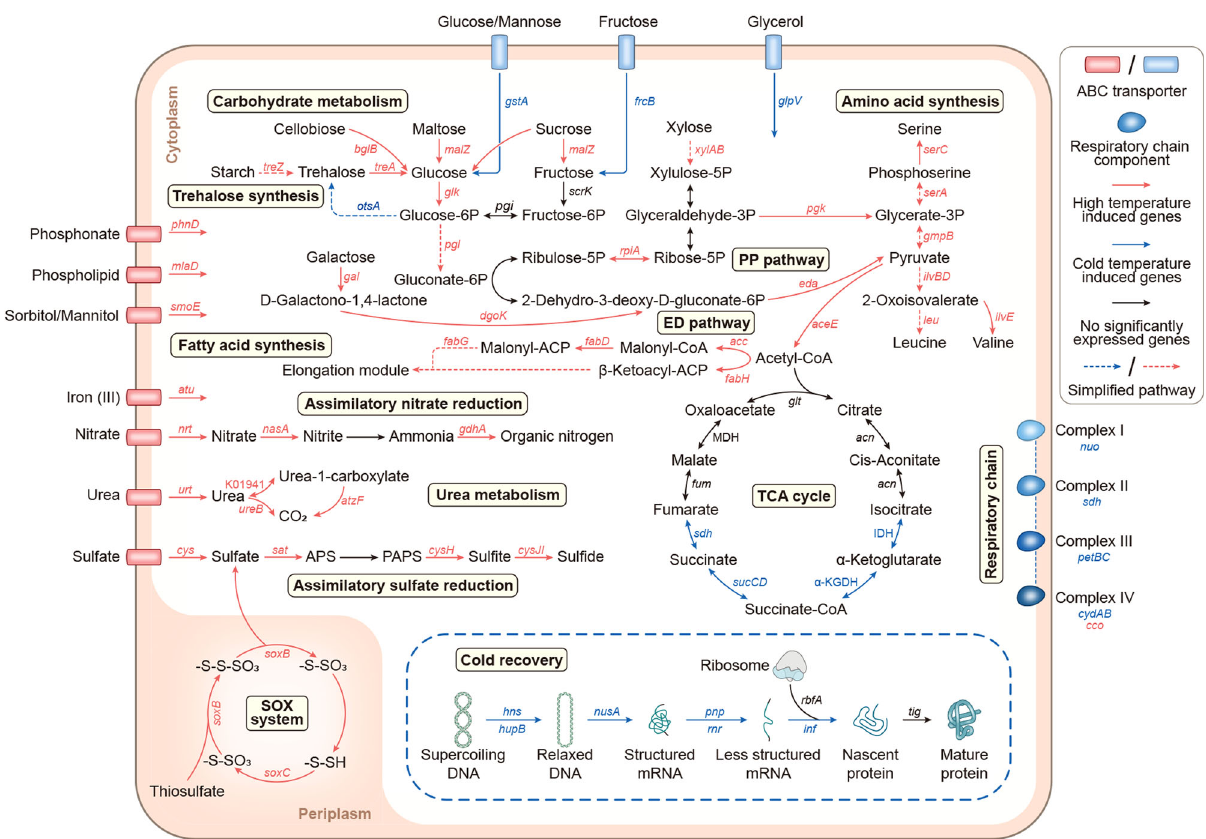
Fig. 4 Differentially transcribed genes and pathways in L. salsilacus with temperature variation. Reads per kilobase per million mapped reads (RPKMs) generated from n = 3 biologically independent samples of each group were used to indicate the gene transcriptions of L. salsilacus grown in marine broth 2216. The signi fi cance of each difference was judged by the absolute value of log 2 (fold-change of RPKMs) >1 and p -value <0.05. Differentially expressed genes associated with the temperature in L. salsilacus were concluded when the number of genes obtained from the pairwise comparisons between different temperatures was ≥ 2. Low-temperature-induced genes and corresponding reactions were labeled with blue, while those that were moderate- temperate-induced are labeled with red. Simpli fi ed pathways were drawn with dashed